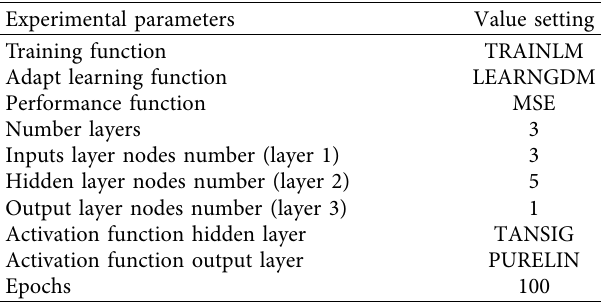
Table 10: Parameter default settings of